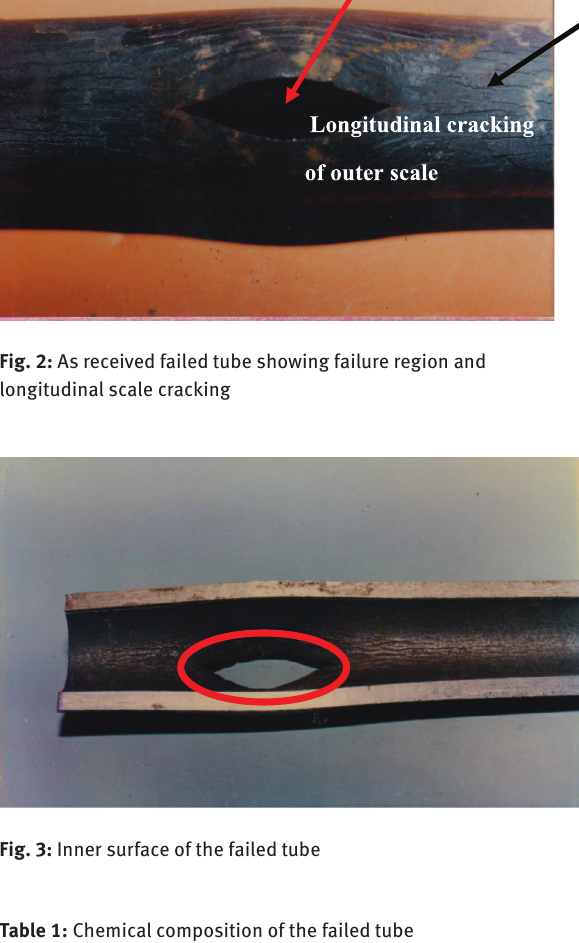
Fig. 1: Location of failure in radiant platen superheater